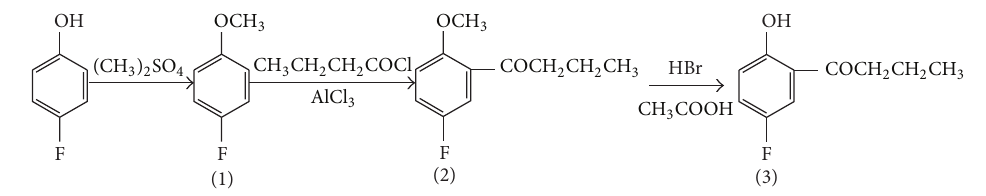
Scheme 1: Synthetic route of 5-fluoro-2-hydroxy